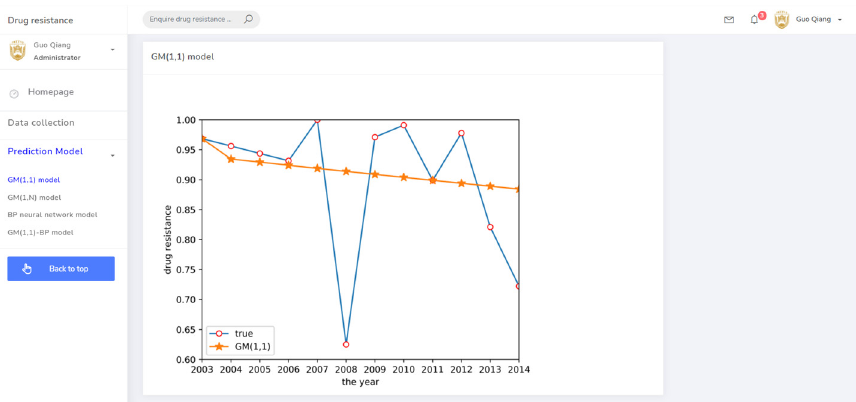
Figure 8. The prediction system page for the GM(1,1) model.